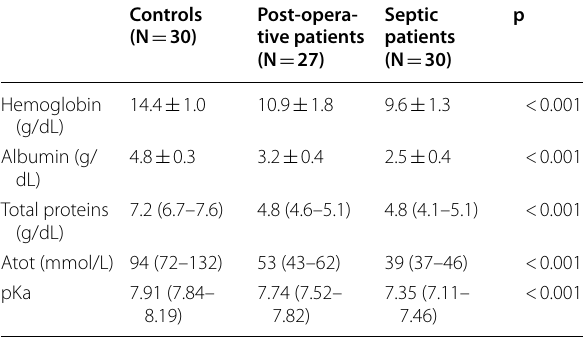
Table 1 Coomparison between nonvolatile buffers concentration (hemoglobin, albumin and total proteins) and the estimated Atot and pKa values among groups Conclusion: Healthy volunteers, septic patients and post-operative patients had different values of both Atot and pKa of whole blood. Of note, both estimates performed through whole blood